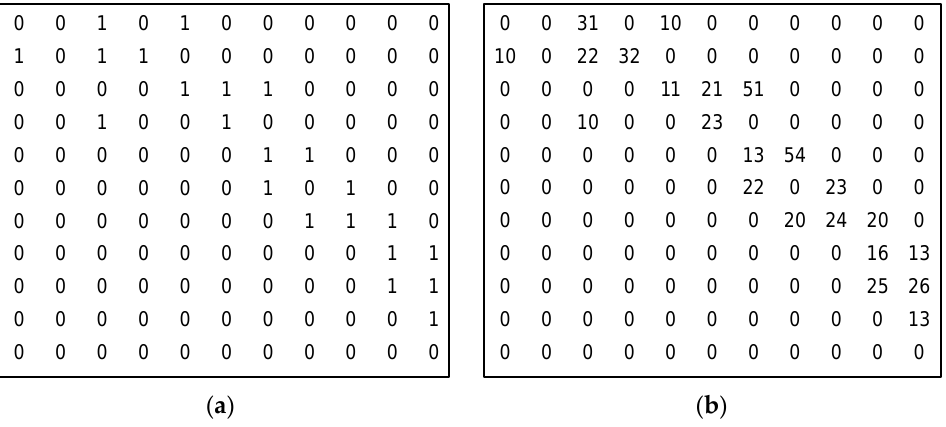
Figure 3. The matrices corresponding to the graph presented in Figure 2: ( a ) edge matrix 𝑊 ′ show- ing the edges of the graph and ( b ) edge weight matrix 𝑊 showing the edge weights.